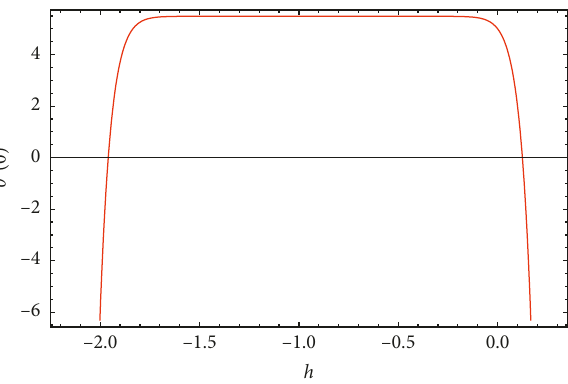
Figure 2: h -curve for velocity field.